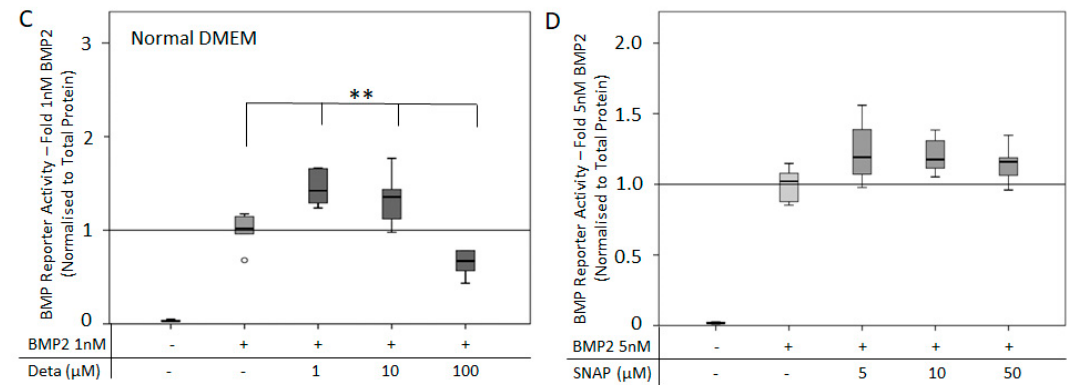
Figure 4. BMP reporter activity after stimulation with the NO donors Deta NONOate and SNAP for